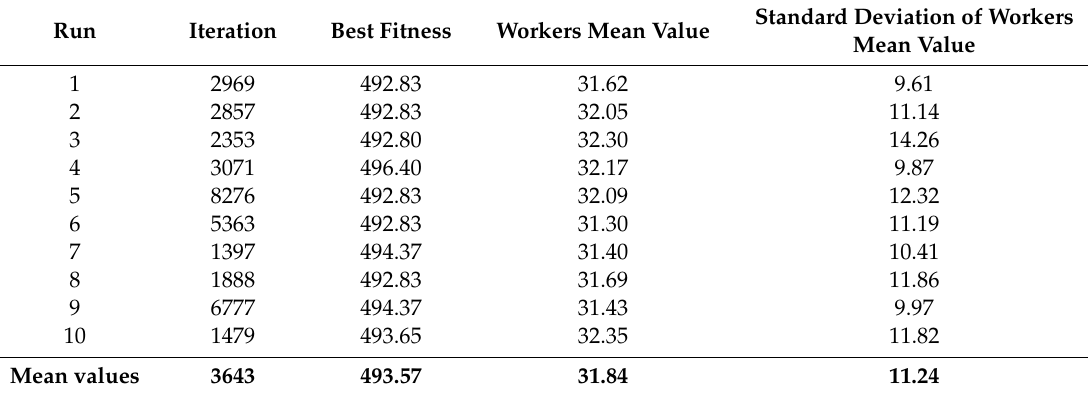
Table 5. Results of the RGA algorithm.